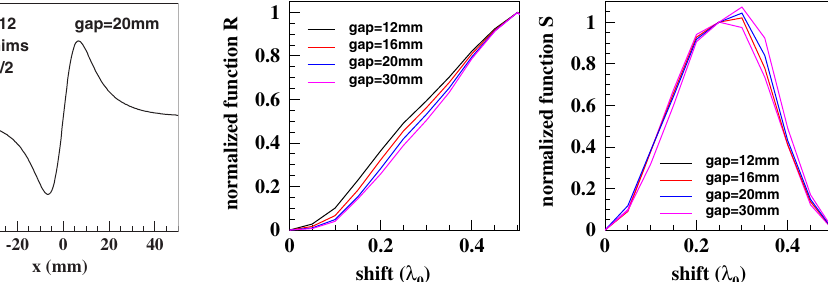
FIG. 6. Generic functions for the description of the L shims. Plotted is the amplitude of a standard L -shim quadruple for the UE112 (see text).